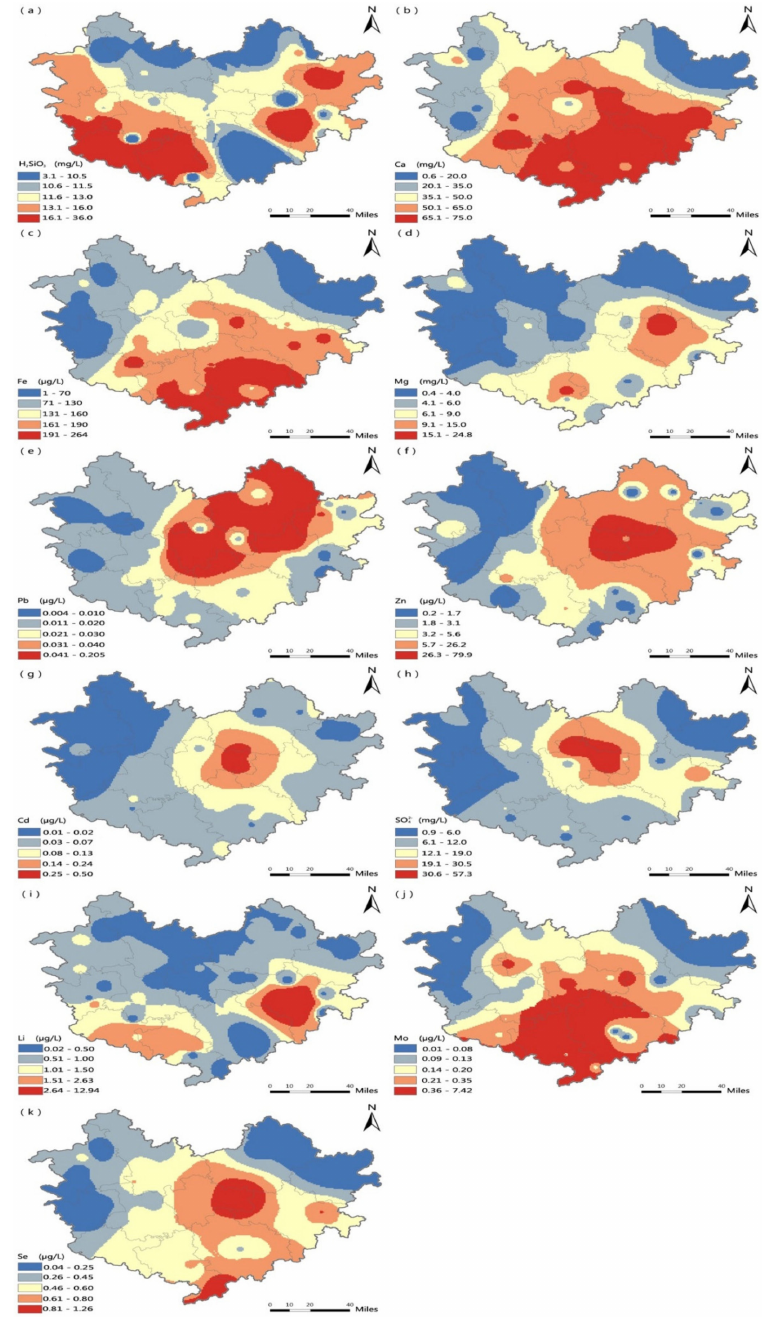
Figure 4. Trace element and mineral levels in drinking water in Hechi: H 2 SiO 3 ( a ), Ca ( b ), Fe ( c ), Mg ( d ), Pb ( e ), Zn ( f ), Cd ( g ), SO 42 − ( h ), Li ( i ), Mo ( j ), Se ( k